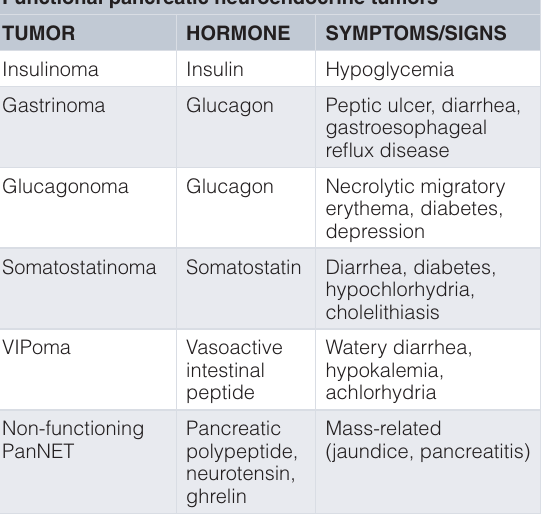
Table 1. Pancreatic neuroendocrine tumors (PanNET): related hormones and clinical